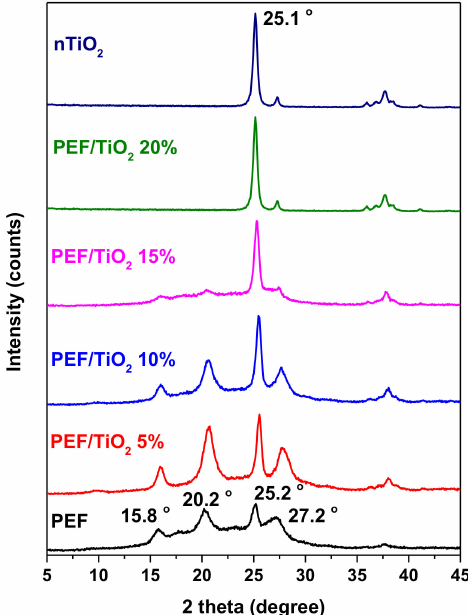
Figure 2. X-ray diffraction patterns of PEF and its nanocomposites with TiO 2